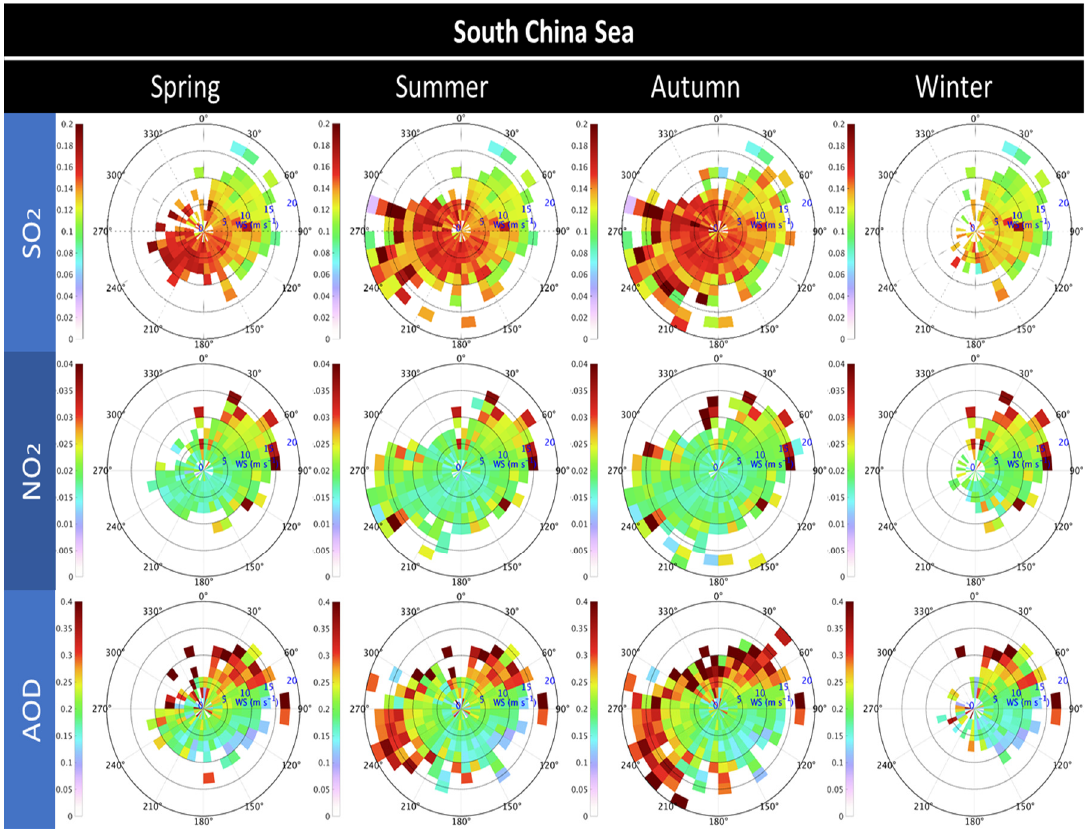
Figure 11. Summary of wind dependency of SO 2 , NO 2 , and AOD in South China Sea for each season. The shading color indicates the value of SO 2 , NO 2 , and AOD. The radial direction and radial distance represent the wind direction and wind speed at 850 mb, respectively.